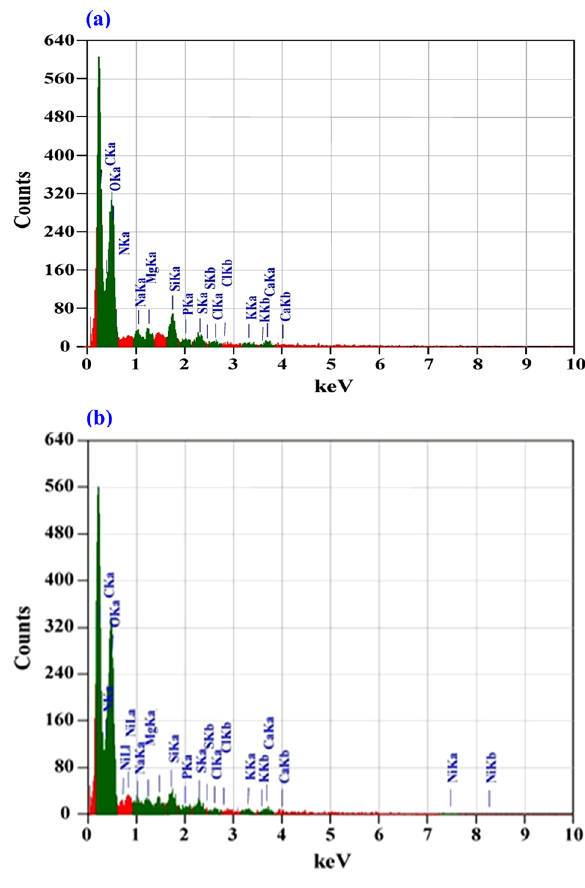
Figure 8: EDS analysis of G. amansii biomass: ( a ) before and ( b ) after adsorption of Ni 2 + ions from aqueous solution. For refer - ence, please see Tables 8 and 9.